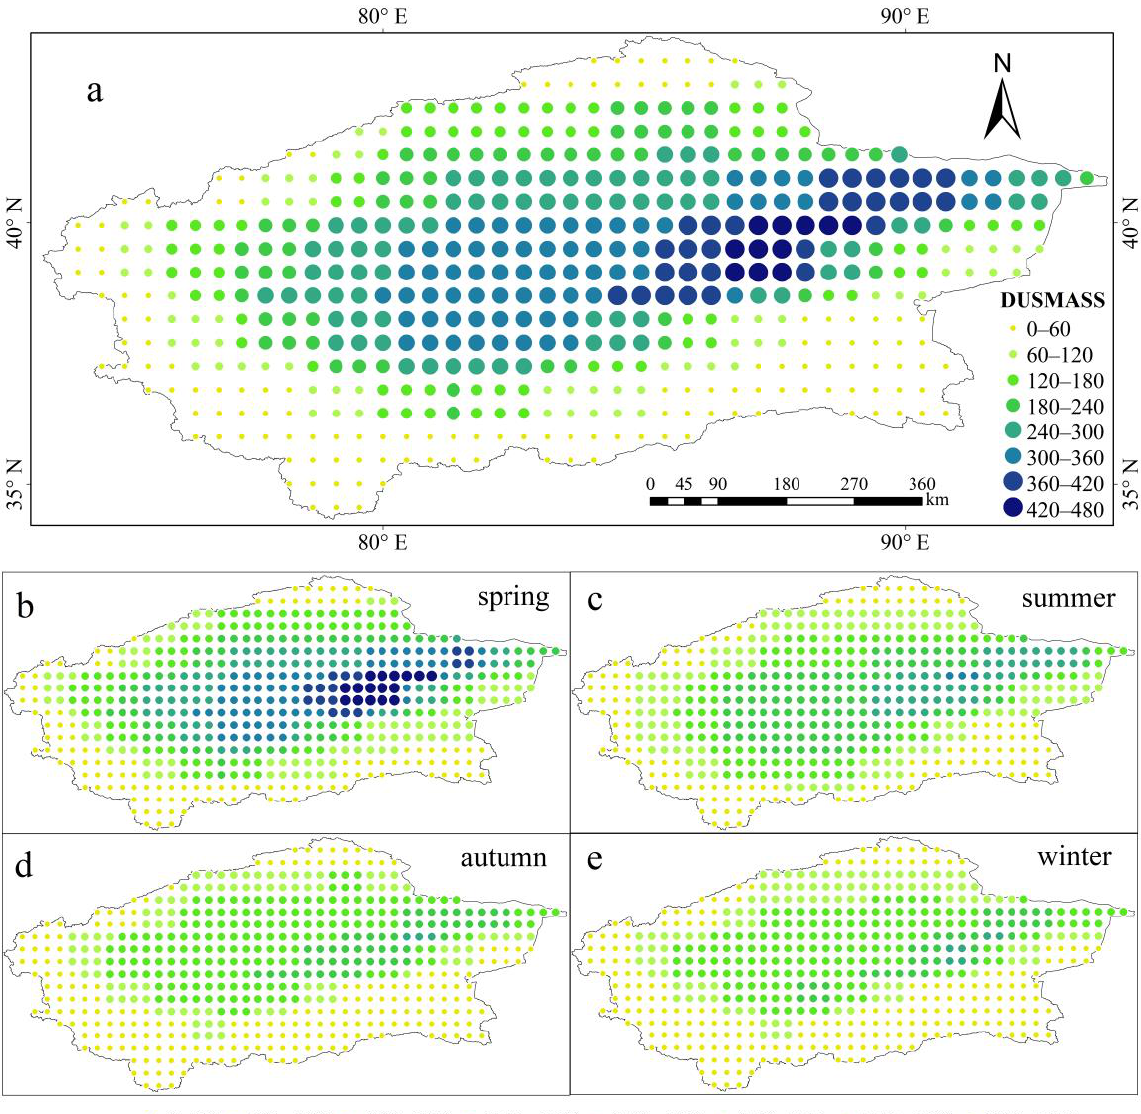
Figure 9. Distribution of dust surface mass concentration ( µ g · m − 3 ) in the Tarim Basin from 1989 to 2021, ( a ) DUSMASS multi-year average distribution; ( b ) DUSMASS in spring; ( c ) DUSMASS in summer; ( d ) DUSMASS in autumn; ( e ) DUSMASS in